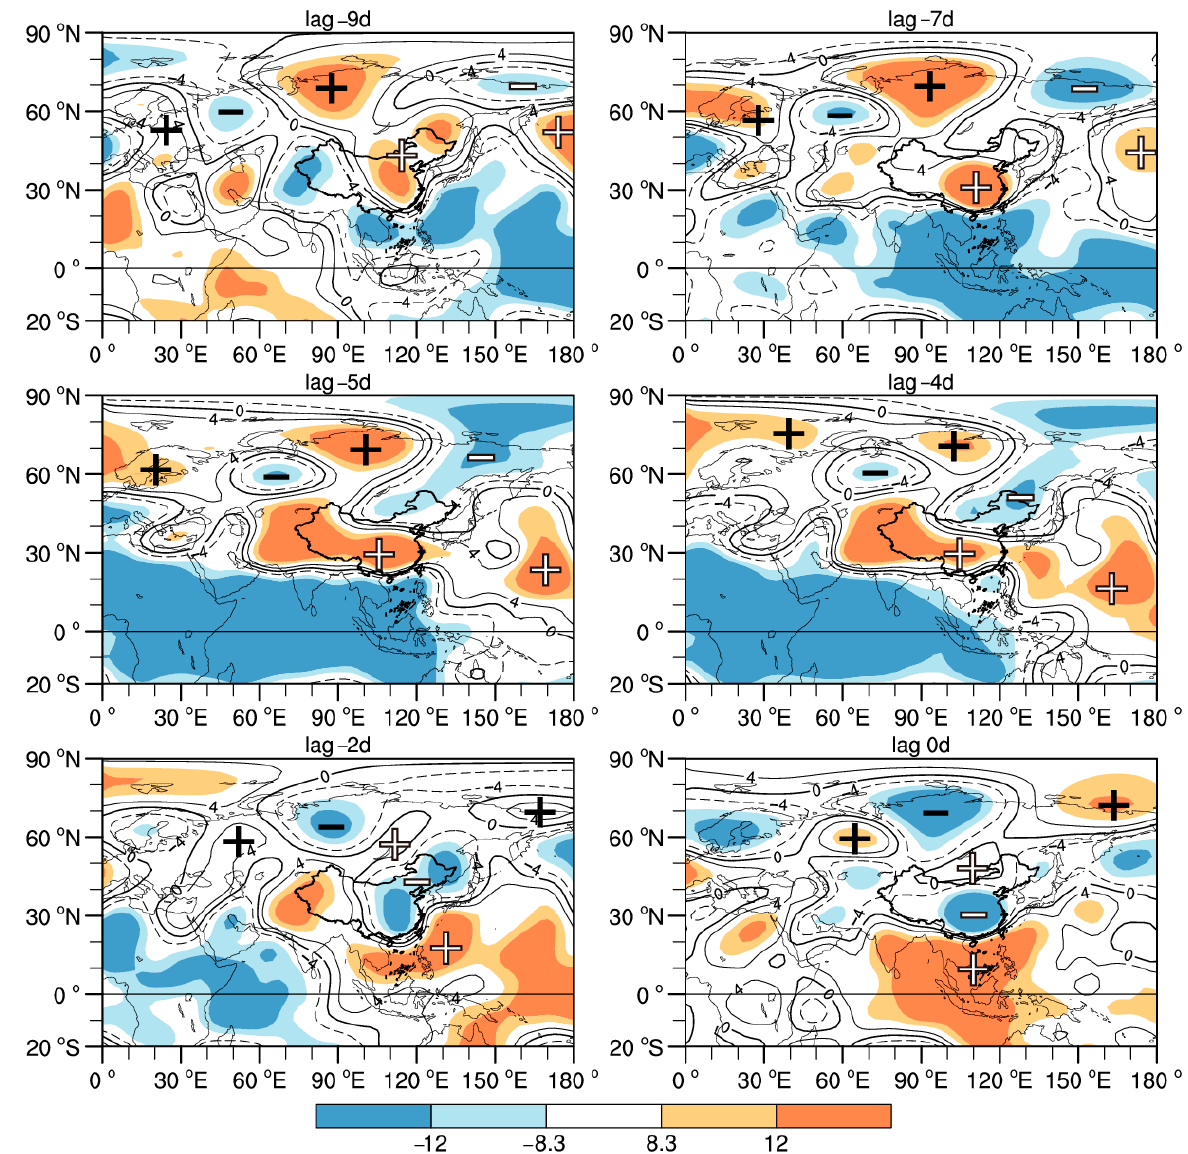
Figure 10. Composite of lead–lag correlation coefficients (shaded and contours, 10 − 2 ) between LF 500 hPa height field 9–0 days ahead and LF summer precipitation time series of flood years in southern China (shaded areas significant at α = 0.1 level). The expression of the negative number of days indicates that the LF 500 hPa height field is ahead of the LF precipitation. The solid and hollow “+”, “ − ”, and “+” on 0 days represent the “two ridges and one trough” system and the EAP teleconnection wave train, respectively.